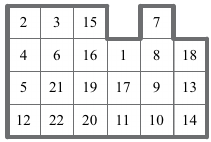
5Fig. 2. The loading sequence of a yard